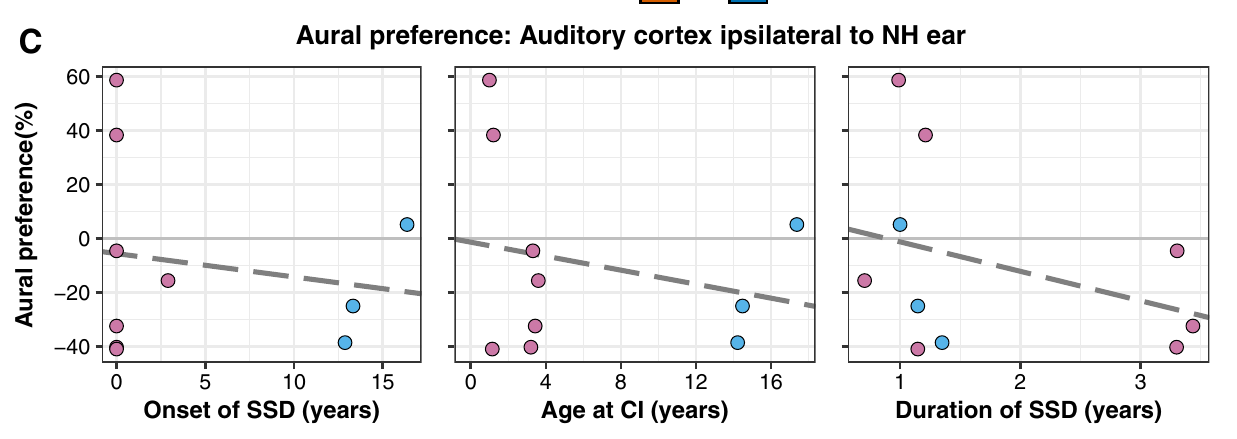
Figure 2. P1 measures and aural preference at initial CI use. (A) Mean (± 1 SE) peak dipole moments in auditory cortices at initial (≤ 1 month) stage of CI activation reveal a trend toward larger responses to the NH than CI ear in both auditory cortices in the late-onset group (p = 0.06, 6 responses in 6 children) but not in the early-onset group (p = 0.81, 15 responses in 11 children). (B) Corresponding mean (± 1 SE) latencies of peak dipoles show faster responses in the late than early-onset group (p < 0.01). (C) Abnormal (grey area) ipsilateral aural preference was measured in 7 of 10 children at this initial stage which could not be significantly predicted by the onset of SSD (p > 0.05), the age at CI (p > 0.05), or the duration of SSD (p > 0.05). ACipsi-CI: Auditory cortex ipsilateral to the CI ear; ACipsi-NH: Auditory cortex ipsilateral to the NH ear. Note: overlapping data points (− 40.86 and − 40.18%) from two children with congenital onset of SSD (0 years) in C-left